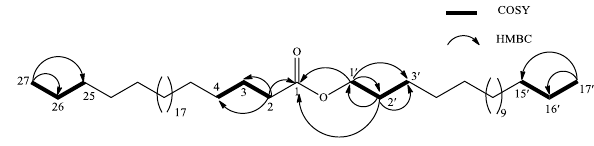
Figure 2. Important COSY and HMBC correlations of compound 4.